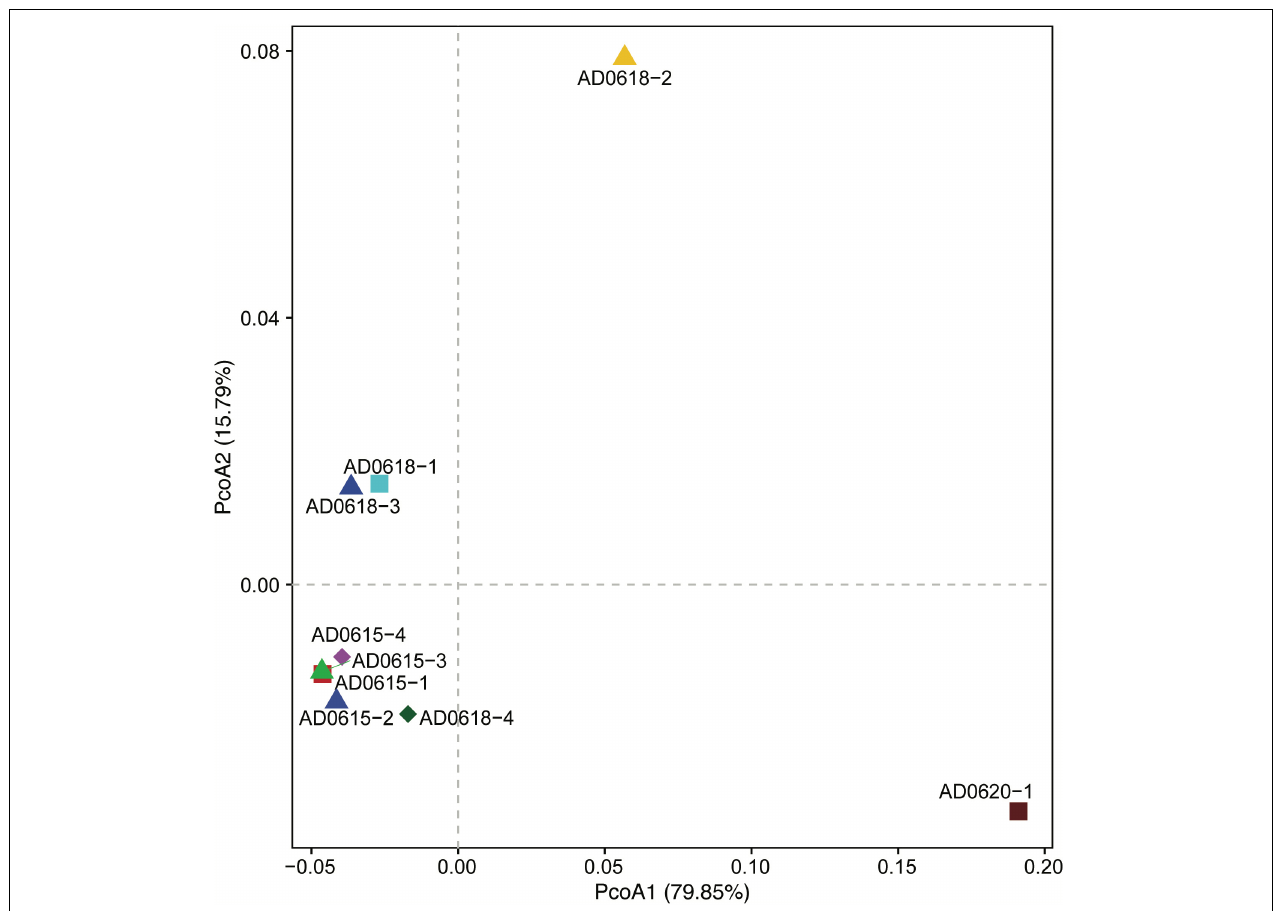
FIGURE 6 | Principal Coordinate Analyses illustrating the similarities and differences of the bacterial communities’ diversity among the nine accessions studied. Axis1 explains 79.85%, and Axis2 explains 15.79% of the total variation. All accessions of ADO615 show high similarity, whereas AD0618 show a stronger differentiation among its four accessions, mainly along